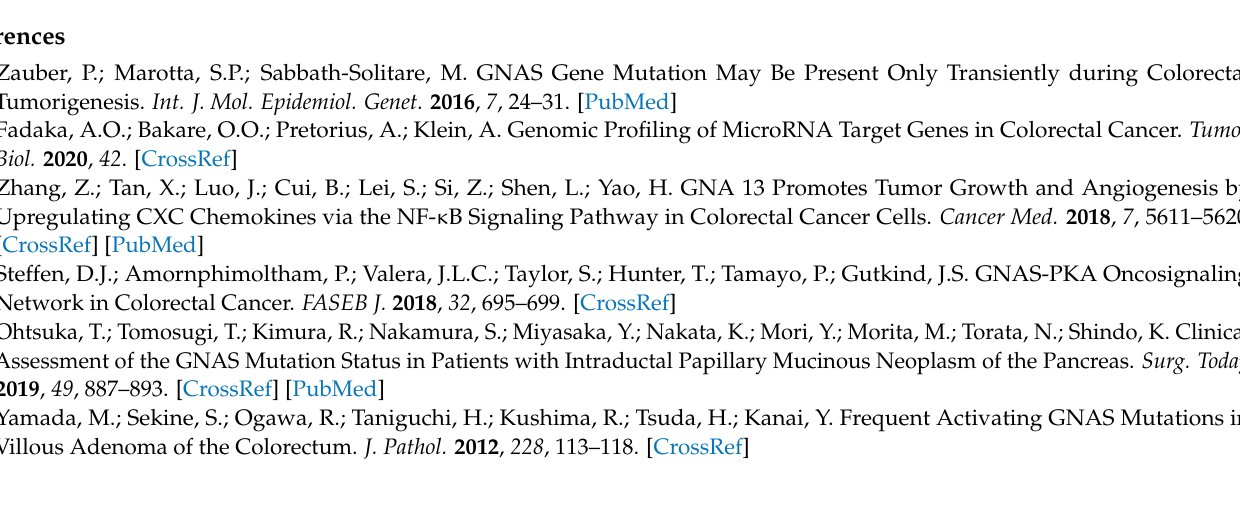
Table S2: The quality of the 30 included studies, Figure S1: GNAS mutation by countries, Figure S2: Gnas Mutation By Gender. Male Gender, Figure S3: GNAS Mutation By Gender. Female Gender, Figure S4: Gnas Mutation by Tumour Stages. Early Stage, Figure S5: GNAS mutation by the Late tumour stage, Figure S6: GNAS mutation by the Well tumour grade, Figure S7: GNAS mutation by the Well tumour grade, Figure S8: GNAS mutation by the Well tumour grade, Figure S9: GNAS mutation by the Moderate tumour grade, Figure S10: GNAS mutation by the Poor tumour grade, Text S1: SEARCH